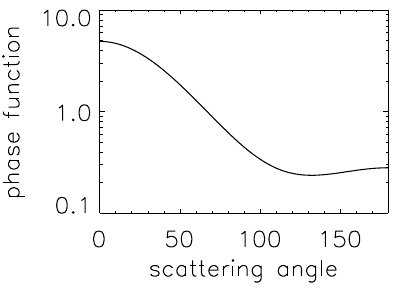
Fig. 3. Phase function of the aerosol model used in this work, which is derived from Mie calculation.